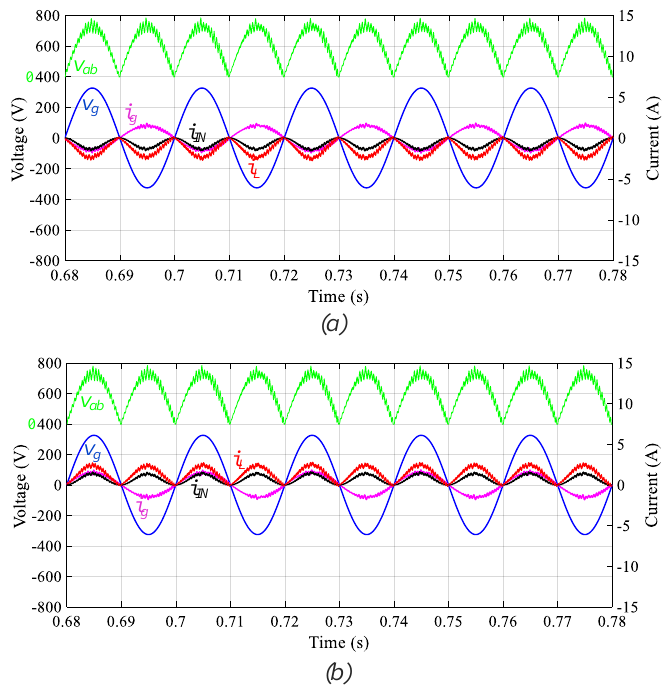
Figure 7. Simulation results for Vout = 250 V, Pin = 250 W in rectifier mode ( a ) and inverter mode with Vin = 250 V ( b ).